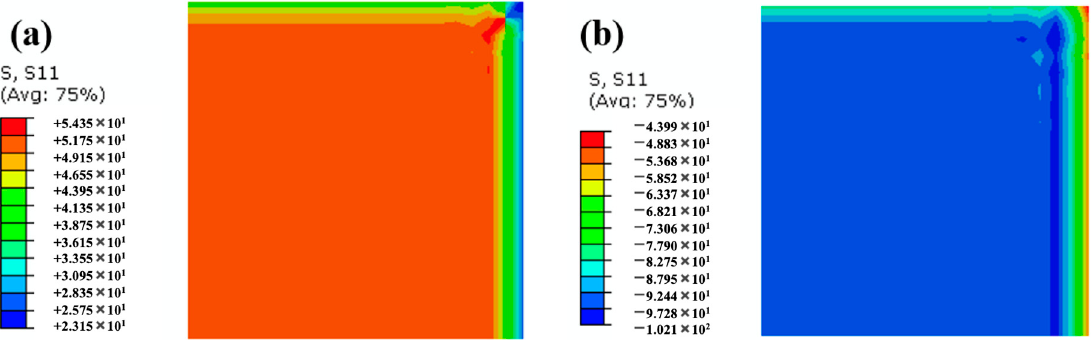
Figure 8. The distribution of final residual stresses in ( a ) aluminum alloy layer and ( b ) GFRP